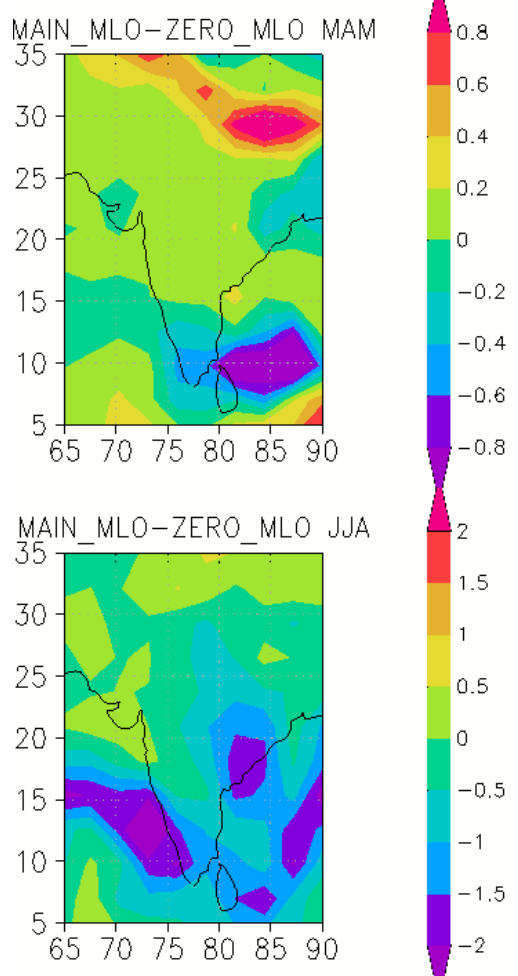
Figure 14. Spatial rainfall anomaly patterns in the mixed-layer ocean simulations for March–May (above) and June–August (be- low), 10-year monthly